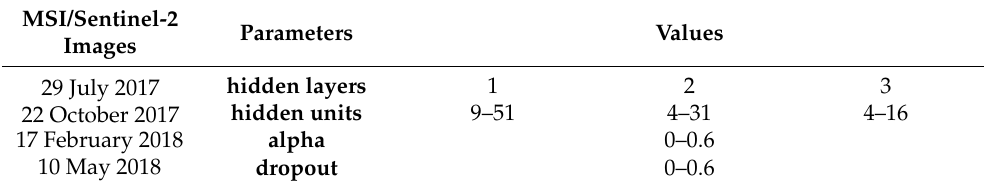
Table 1. Image dates used and parameters optimized in the MLP network